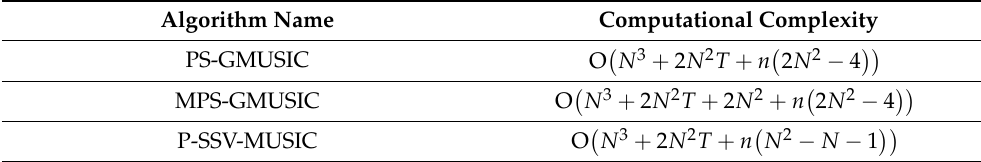
Table 2. Computational complexity of three algorithms.